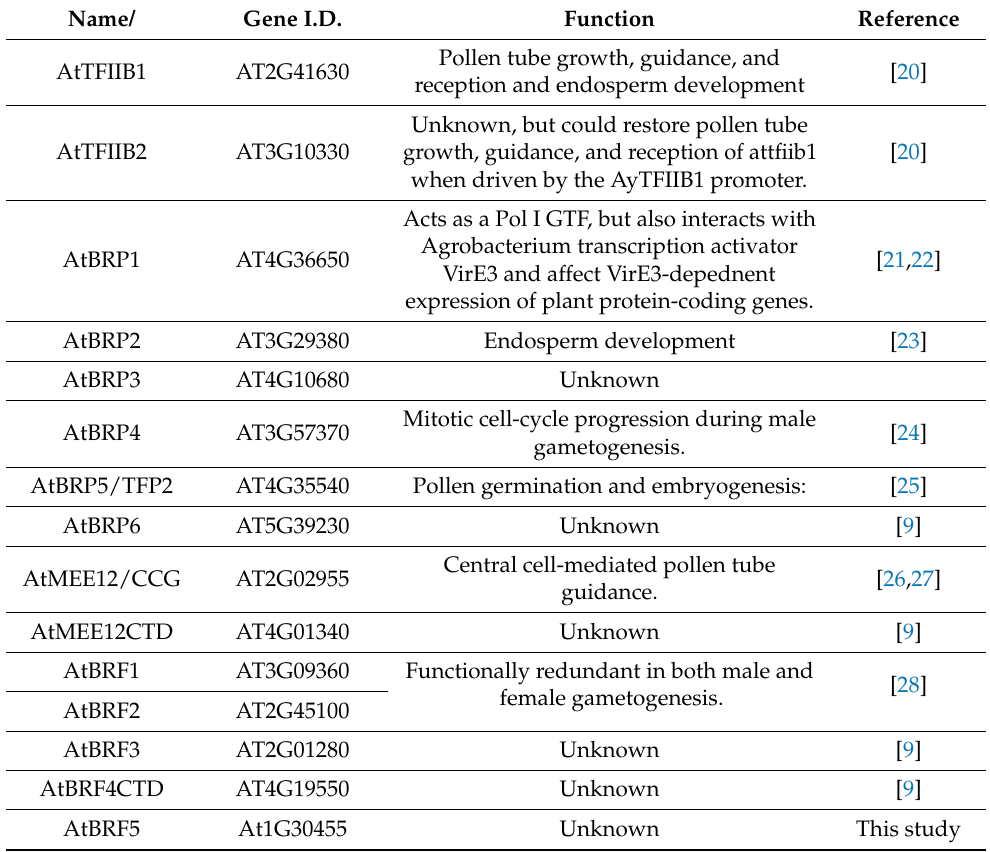
Table 1. Functional analysis of Arabidopsis TFIIB-like